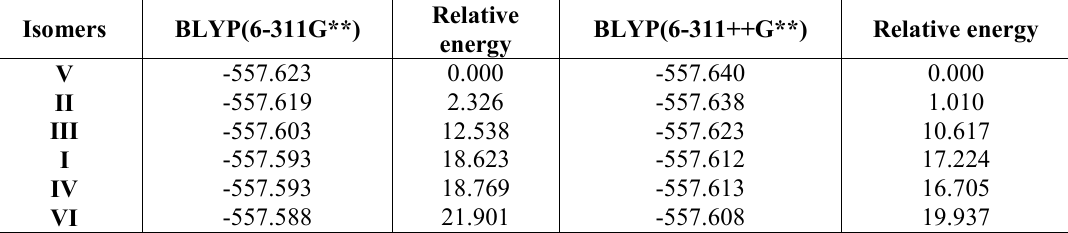
Table 1. Energies (Hartree) and Relative Energies (kcal/mol) of Optimized Isomers (BLYP/6-311G**, 6-311++G**) of the Isolated Glycylglycine–Zn 2+ Complexes in Gas Phase.